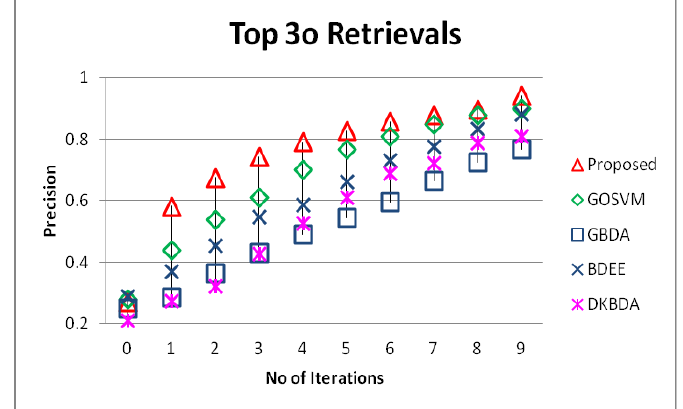
Figure 11. Comparison of the proposed method in terms of precision on top 30 retrievals against genetically optimized support vector machines (GOSVM), generalized biased discriminant analysis (GBDA), biased discriminant euclidean embedding (BDEE) and direct kernel biased discriminant analysis (DKBDA).